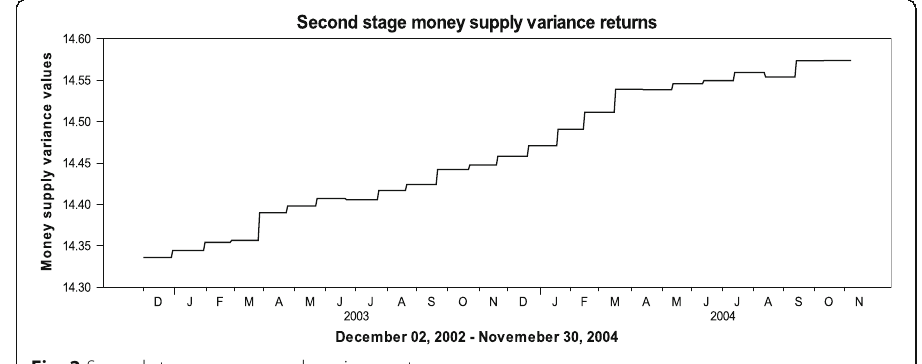
Fig. 2 Second stage money supply variance